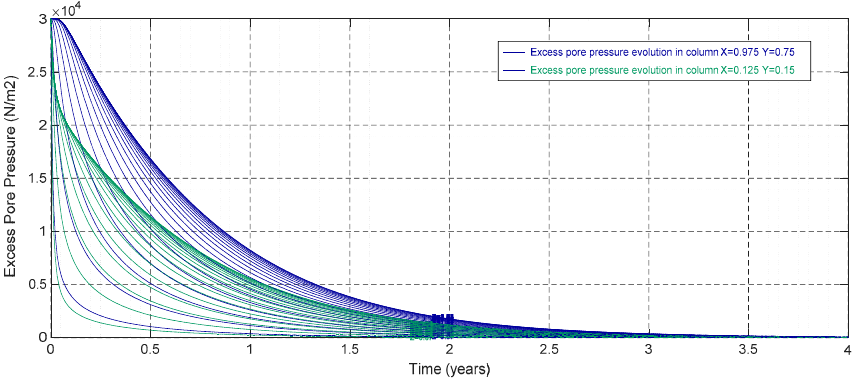
Figure 11. Excess pore pressure evolution in two soil columns (N z = 20).